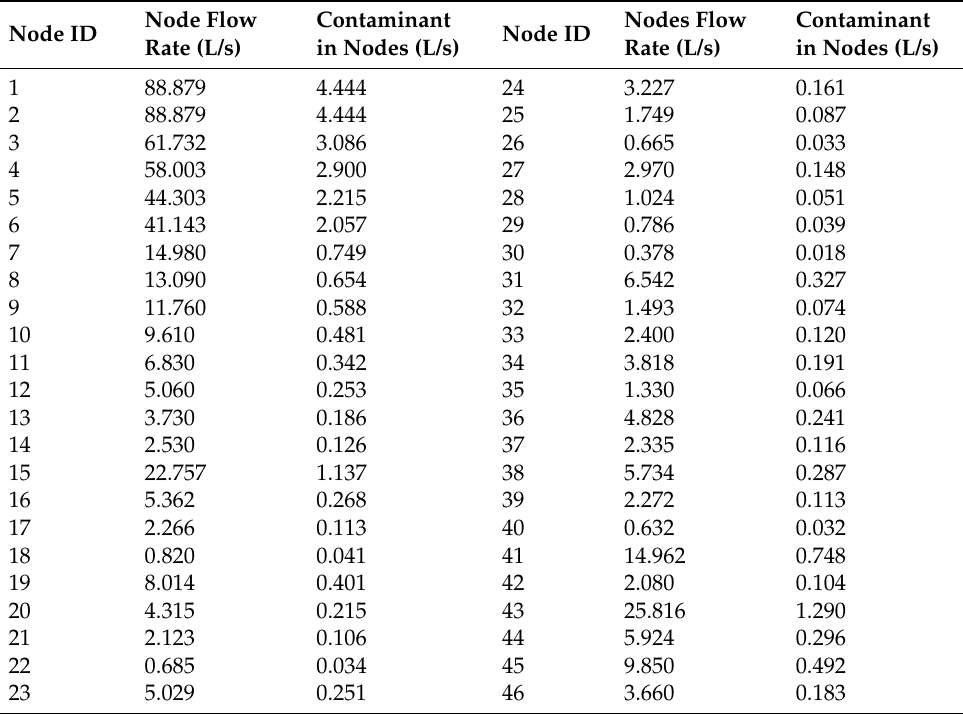
Table 5. Numerical results for node and contaminant flow for Illustrative Example